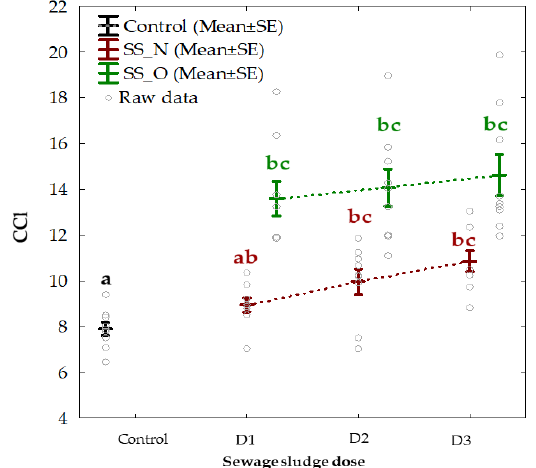
Figure 1. Changes in the relative chlorophyll content in leaves depending on the type and dose of sewage sludge (mean values from the experiment series). Mean values ( n = 9) ± standard error. Identical superscripts denote no significant ( p > 0.05) differences between the experimental variants according to the post hoc Tukey HSD test. Explanation: SS_N—non-ozonated sewage sludge; SS_O—ozonated sewage sludge; D1, D2, D3—dose of sewage sludge—3, 6, 9 Mg ha − 1 , respectively.